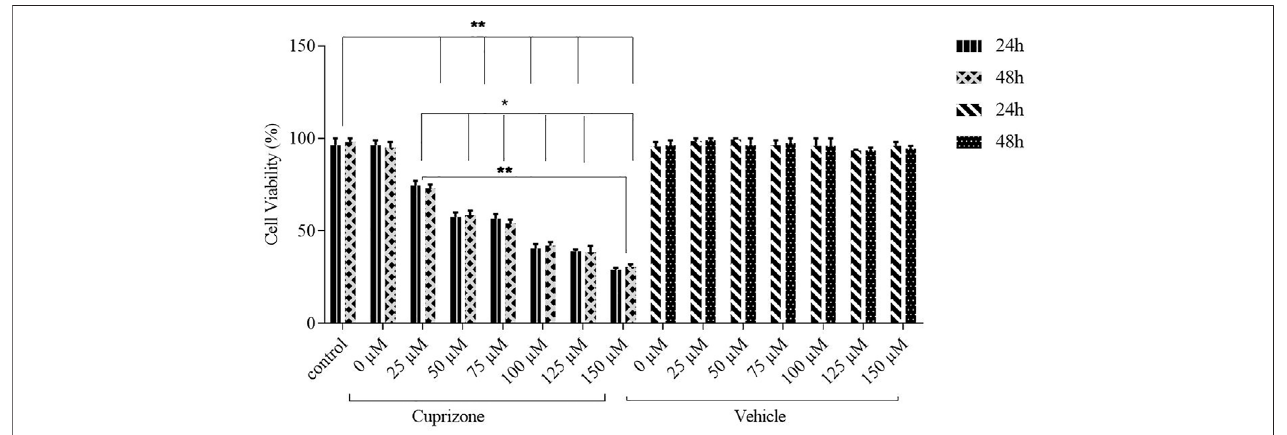
FIGURE 2 | A diagram that shows the IC 50 of cuprizone for induction of cell death in the oligodendrocyte cell line after 24 h.